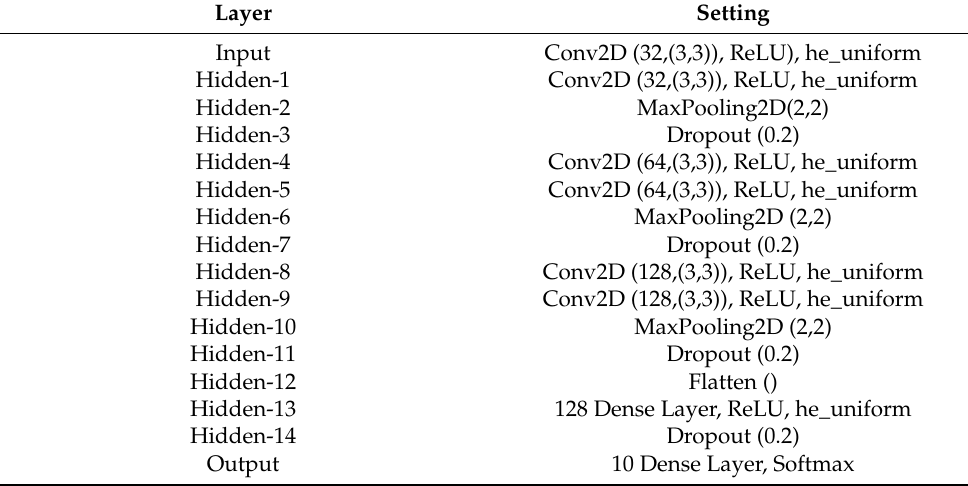
Table 3. Classification model